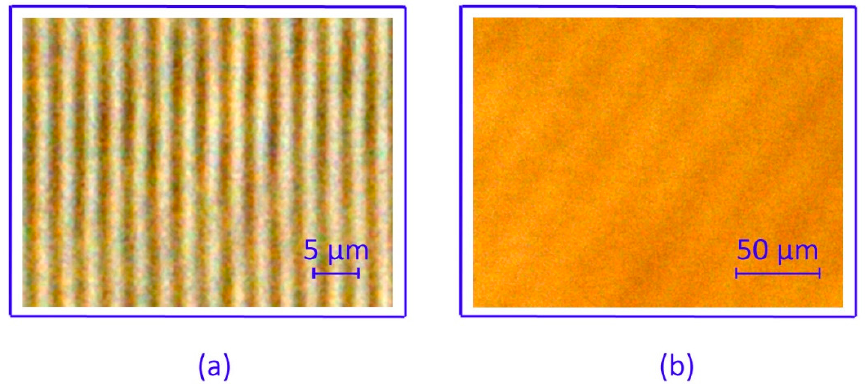
Figure 1. Light-microscopic image (false color display) of ( a ) transmission grating and ( b ) reflection grating in cross-sectional view.